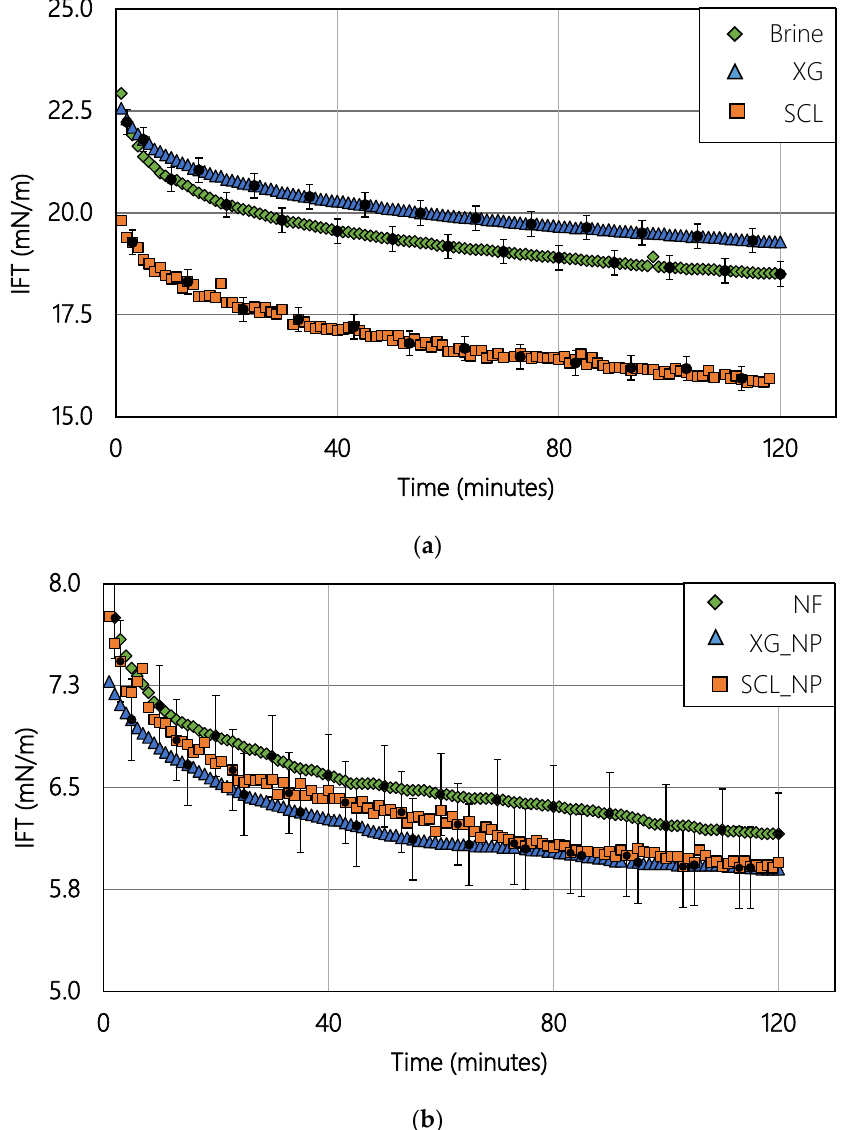
Figure 4. ( a ) Interfacial tension-free of NPs and ( b ) Interfacial tension in solutions with NPs.